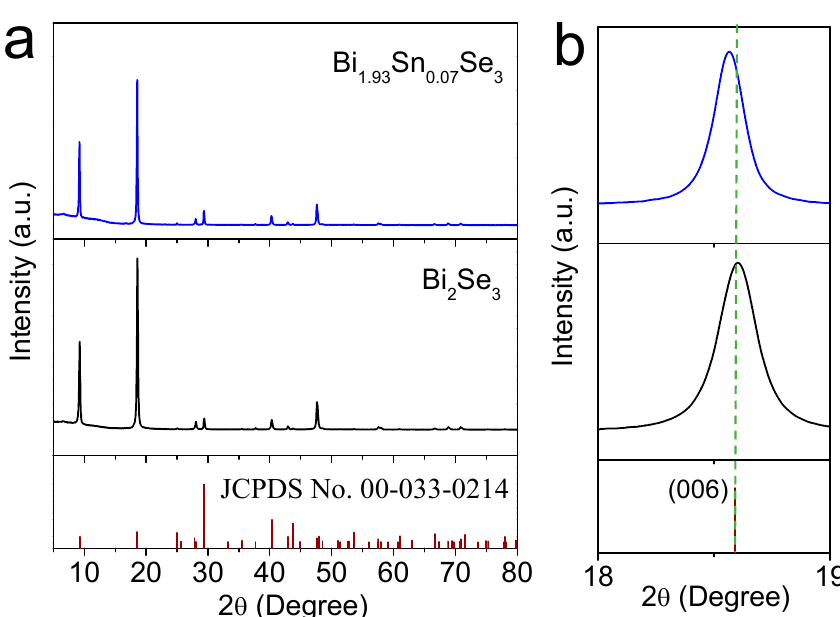
Figure 6. ( a ) XRD patterns of Bi 2 Se 3 and Bi 1.93 Sn 0.07 Se 3 ; ( b ) expansion diagram of the area corresponding to the diffraction peak of Bi 2 Se 3 (006).